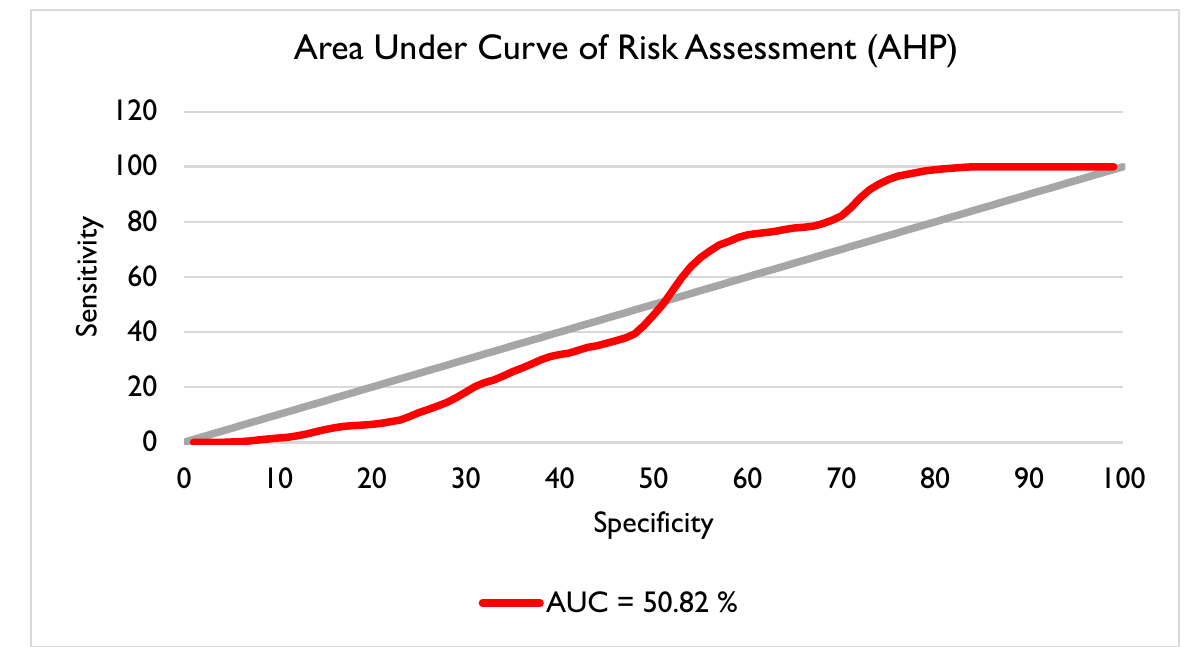
Figure 16. Area Under the Curve conducted for risk assessment created from AHP.